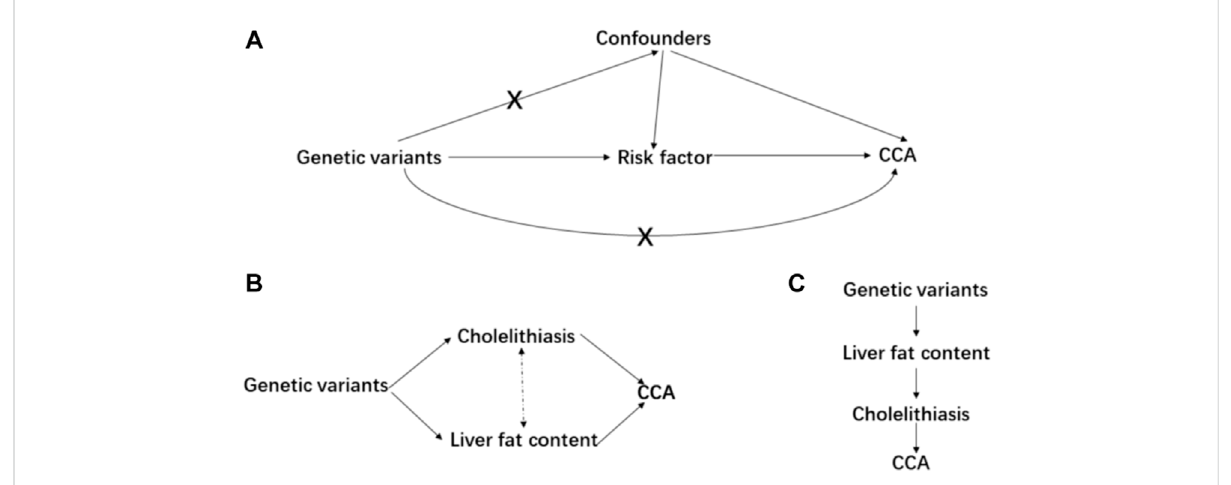
FIGURE 1 Main design of this study. (A) consists of the basic assumptions of the Mendelian randomization; (B) is the design of multivariable MR; and (C) is the design of mediation